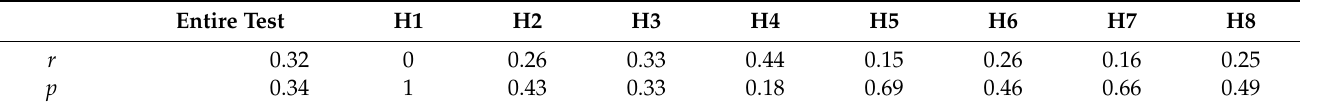
Table 2. Pearson correlation coefficients ( r ) and significance level ( p) between energy expenditure via spiroergometry and via local position measurement system for the entire test and every single heat (H1–H8).